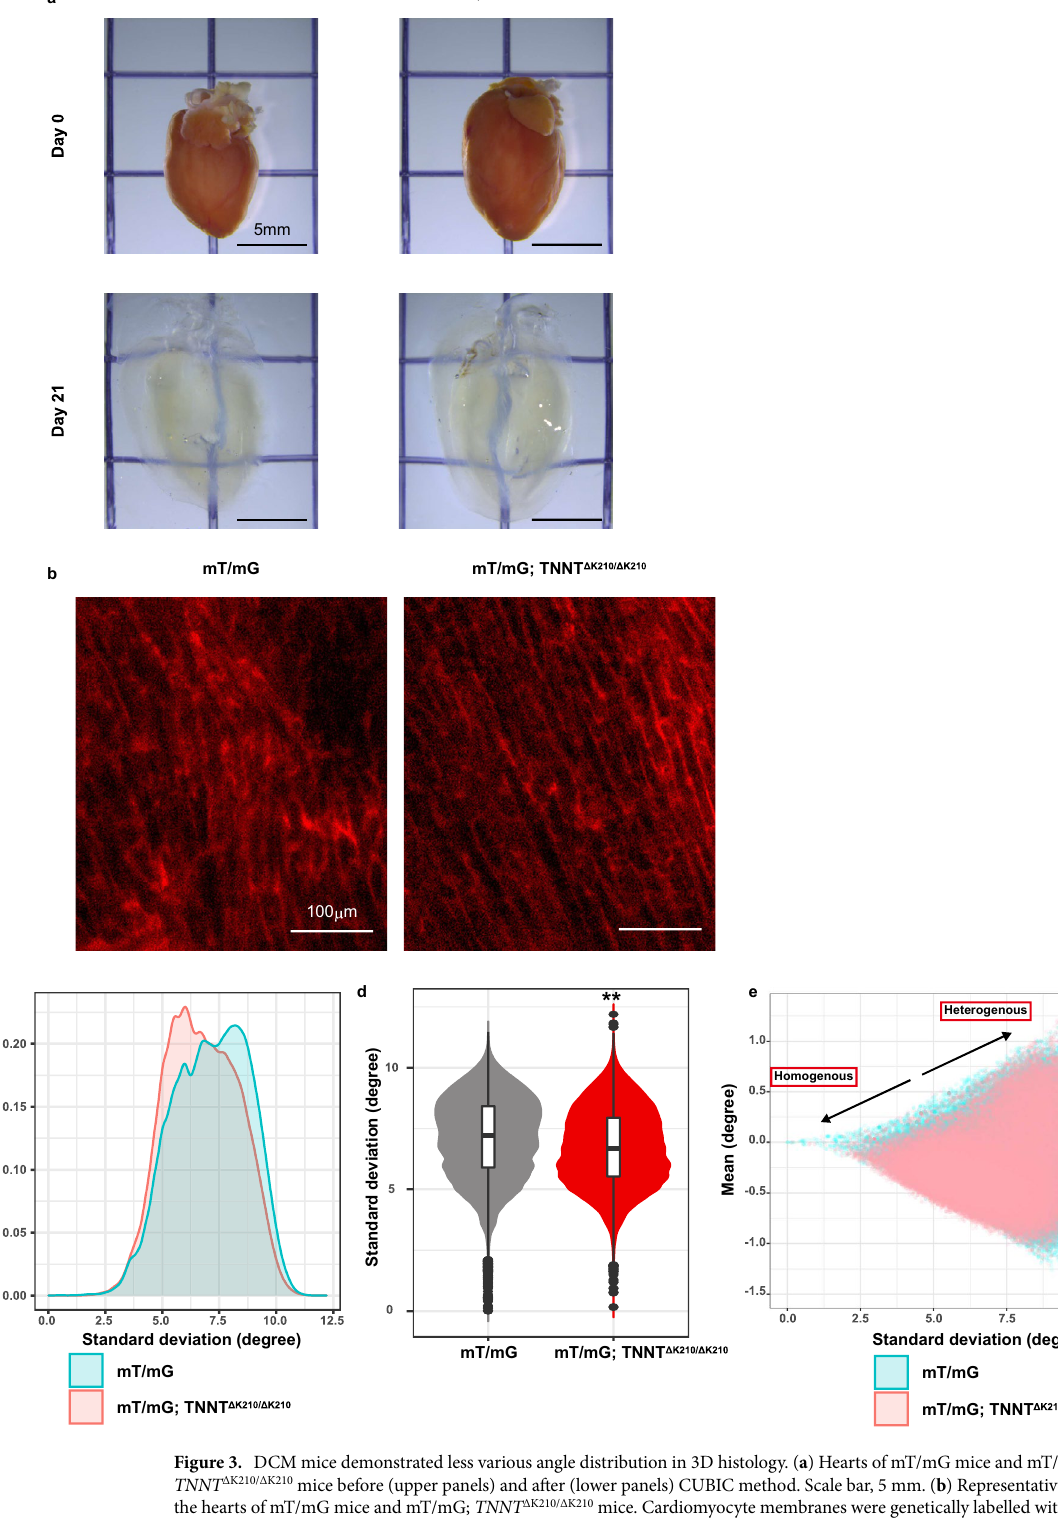
Figure 3. DCM mice demonstrated less various angle distribution in 3D histology. ( a ) Hearts of mT/mG mice and mT/mG; TNNT ΔK210/ΔK210 mice before (upper panels) and after (lower panels) CUBIC method. Scale bar, 5 mm. ( b ) Representative 2D image of the hearts of mT/mG mice and mT/mG; TNNT ΔK210/ΔK210 mice. Cardiomyocyte membranes were genetically labelled with a Tomato fluorescent reporter protein (red). Scale bar, 100 μm. ( c–e ) Quantitative analysis of cardiomyocyte alignment in mT/mG mice and mT/mG; TNNT ΔK210/ΔK210 mice. Distribution of Standard deviation (SD) of mT/mG mice and mT/mG; TNNT ΔK210/ΔK210 mice ( c ). SD of the orientation in cell neighbourhoods were statistically analysed between mT/mG mice and mT/mG; TNNT ΔK210/ΔK210 mice ( d ). Visualisation of all orientations in mT/mG mice and mT/mG; TNNT ΔK210/ΔK210 mice by plotting according to SD and mean orientations in neighbours. Dots located in upper right direction mean local heterogeneous alignment, whilst those located in lower left direction mean local homogeneous alignment. ( e ) Statistical significance was determined by unpaired two-tailed Student’s t-test. ** P < 0.01 versus mT/mG mice. A box and a line above/below the box indicate SD and 95% confidence interval, respectively. All statistical analyses were performed with the R software and ( c–e ) were created using the R